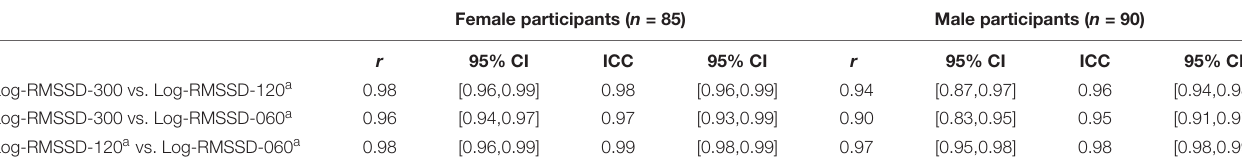
TABLE 5 | Correspondence between short-term and ultra-short-term measures of heart rate variability.